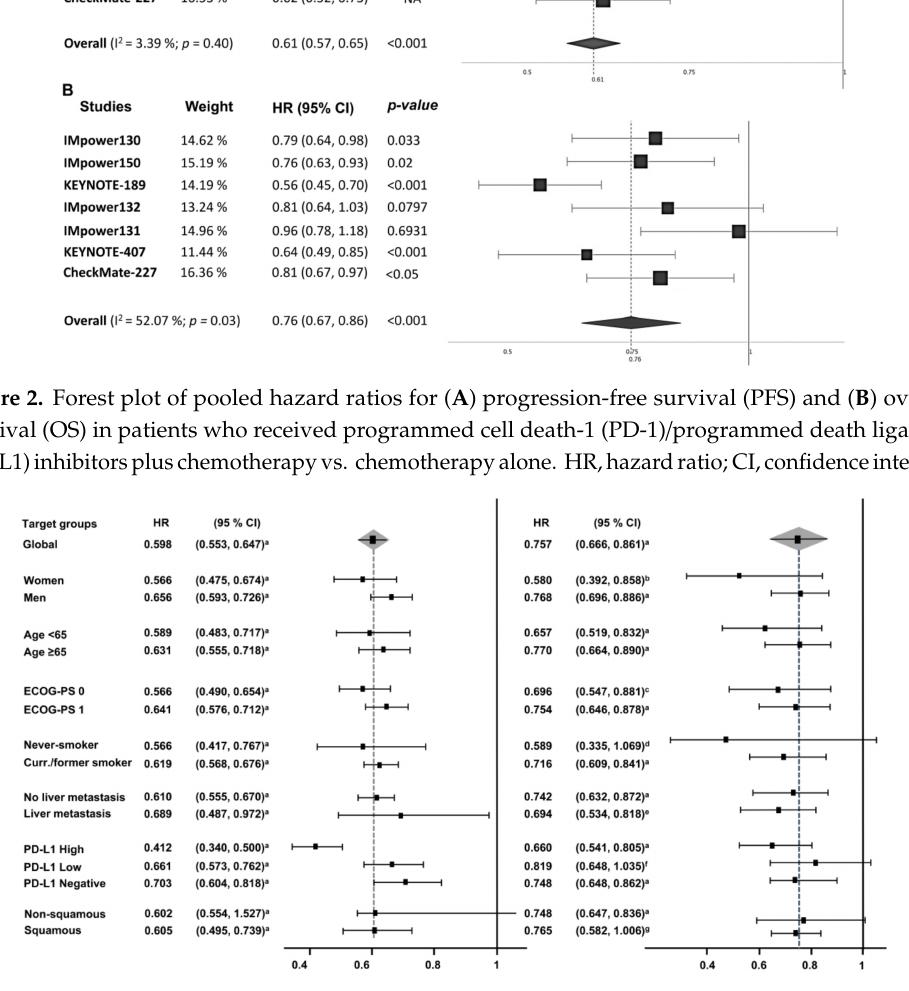
Figure 3. Forest plot of hazard ratios for progression-free survival (PFS) and overall survival (OS) in the subgroup analysis. PFS, progression-free survival; OS, overall survival. HR, hazard ratio; CI, confidence interval; Curr., current.; a p < 0.001; b p = 0.006; c p = 0.003; d p = 0.082; e p = 0.007 ; f p = 0.093; g p =